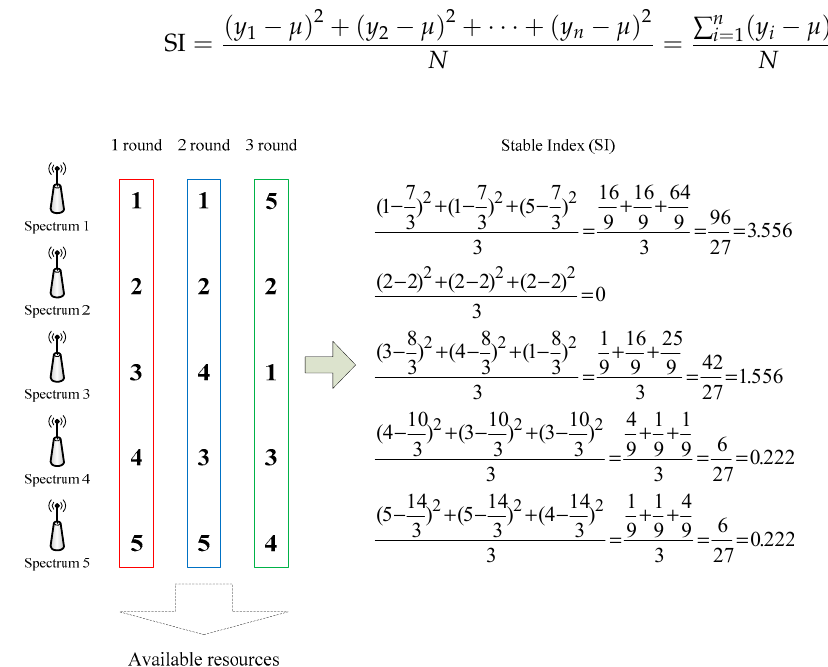
Figure 8. An example of scanning three rounds.